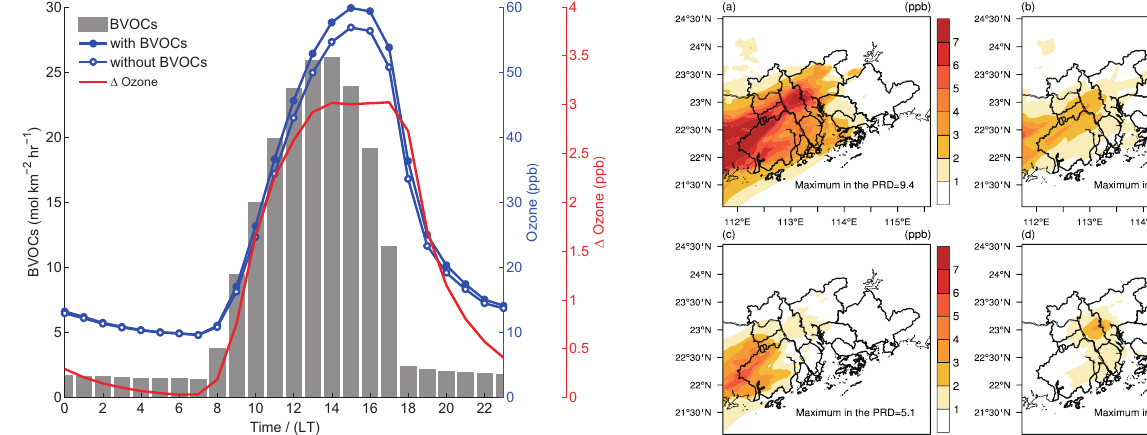
Fig. 6. Changes of the surface ozone peak due to BVOC emissions: (a) spatial distribution of surface ozone changes due to BVOC emis- sions from the whole domain; (b) spatial distribution of surface ozone changes due to BVOC emissions from the outside PRD; (c) spatial distribution of surface ozone changes due to BVOC emis- sions from the rural PRD; (d) spatial distribution of surface ozone changes due to BVOC emissions from the central